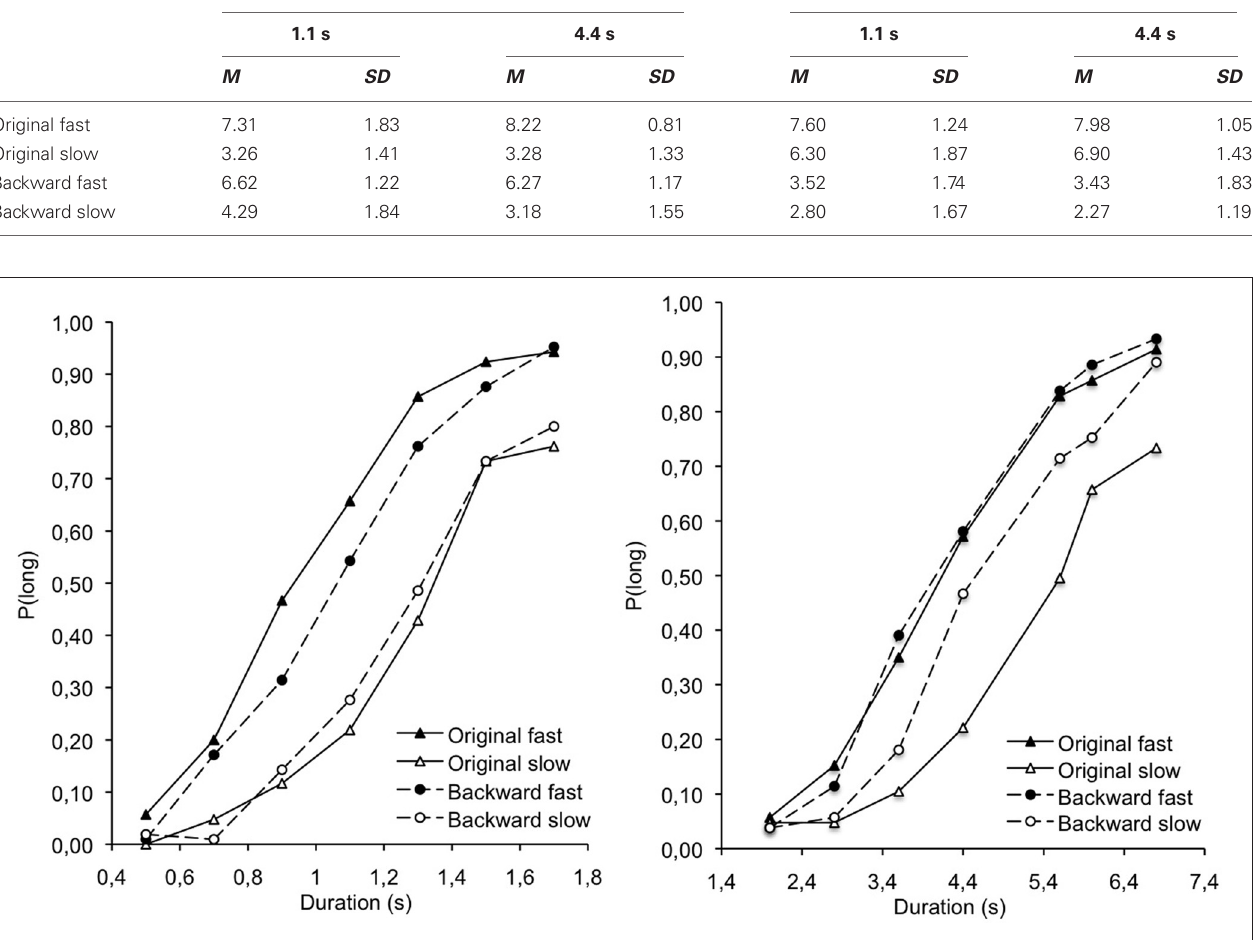
FIGURE 1 | Proportion of long responses plotted against stimulus duration for the original and the backward music with a slow and fast tempo in the 0.5–1.7 and the 2.0–6.8s duration